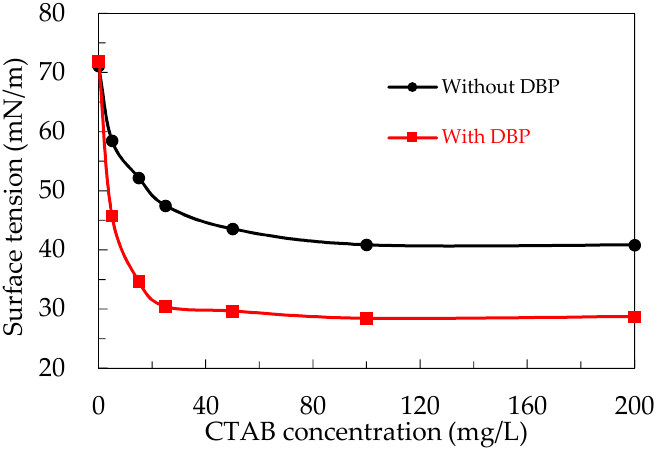
Figure 4. Effects of CTAB concentration on solution surface tension at pH 6.0 without DBP and with DBP at a DBP/CTAB mass ratio of 1:5.